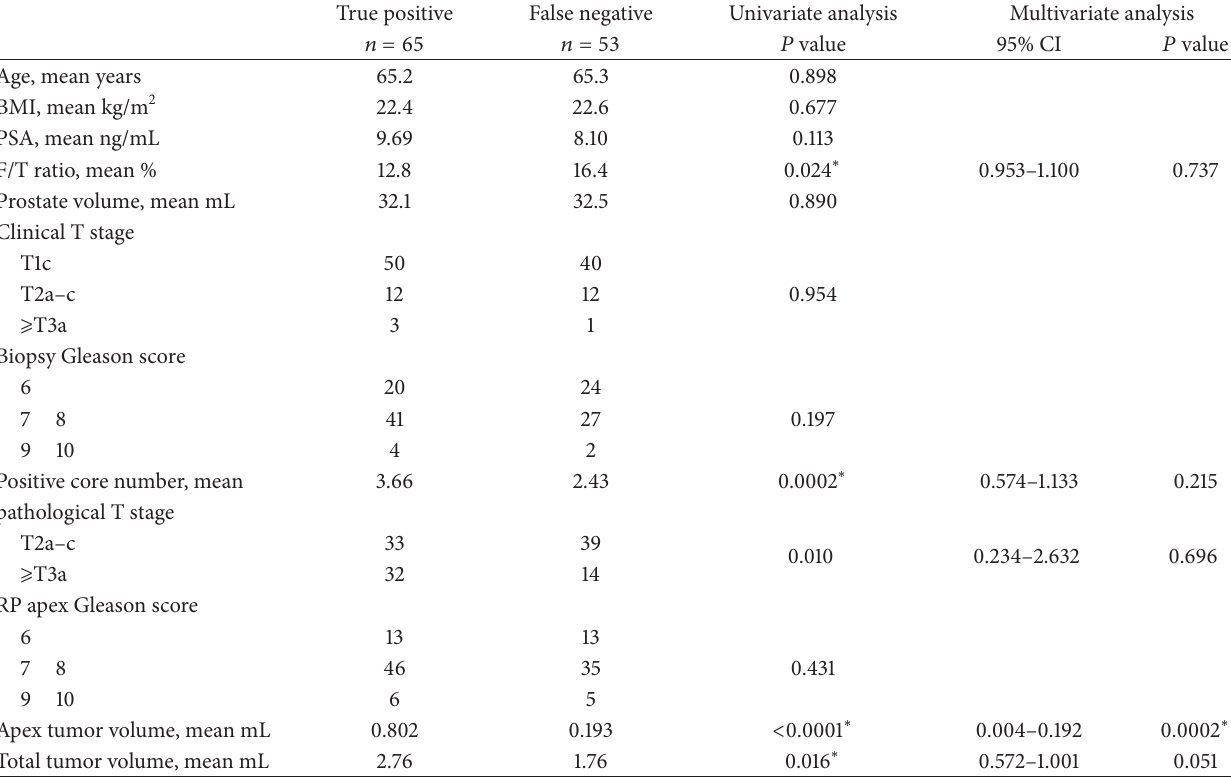
Table 4: Univariate and multivariate analysis of factors for detecting apex cancer among clinicopathological